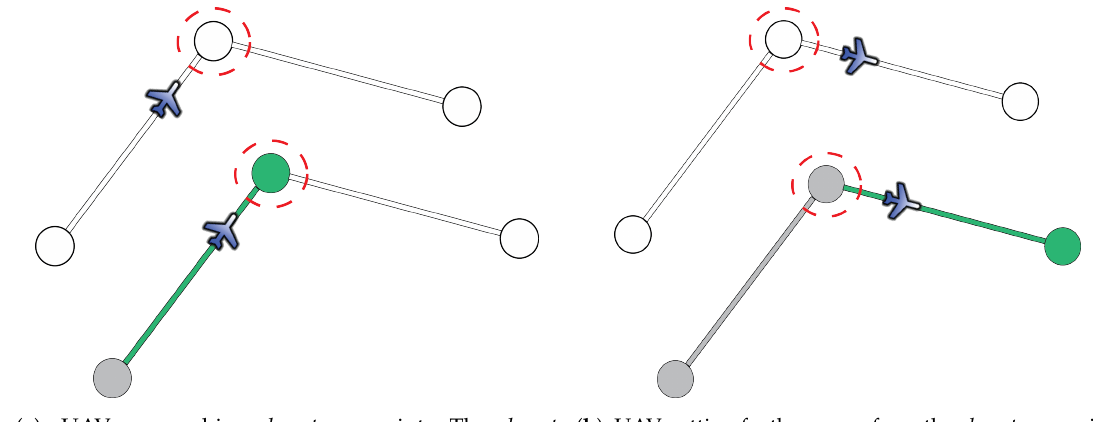
Figure 6. Initialization process of the flying route. The top of each subfigure shows the UAV situation with respect to the closest waypoint (in red). The bottom of each subfigure shows the color coding of the legs and waypoints that will be presented to the operator. The upcoming waypoint and the currently flown leg are always displayed in